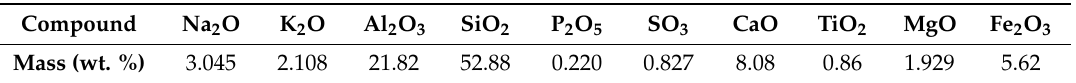
Table 4. Chemical composition of the fly ash used to prepare PAA-AM/FA composite using X-ray fluorescence spectrometer